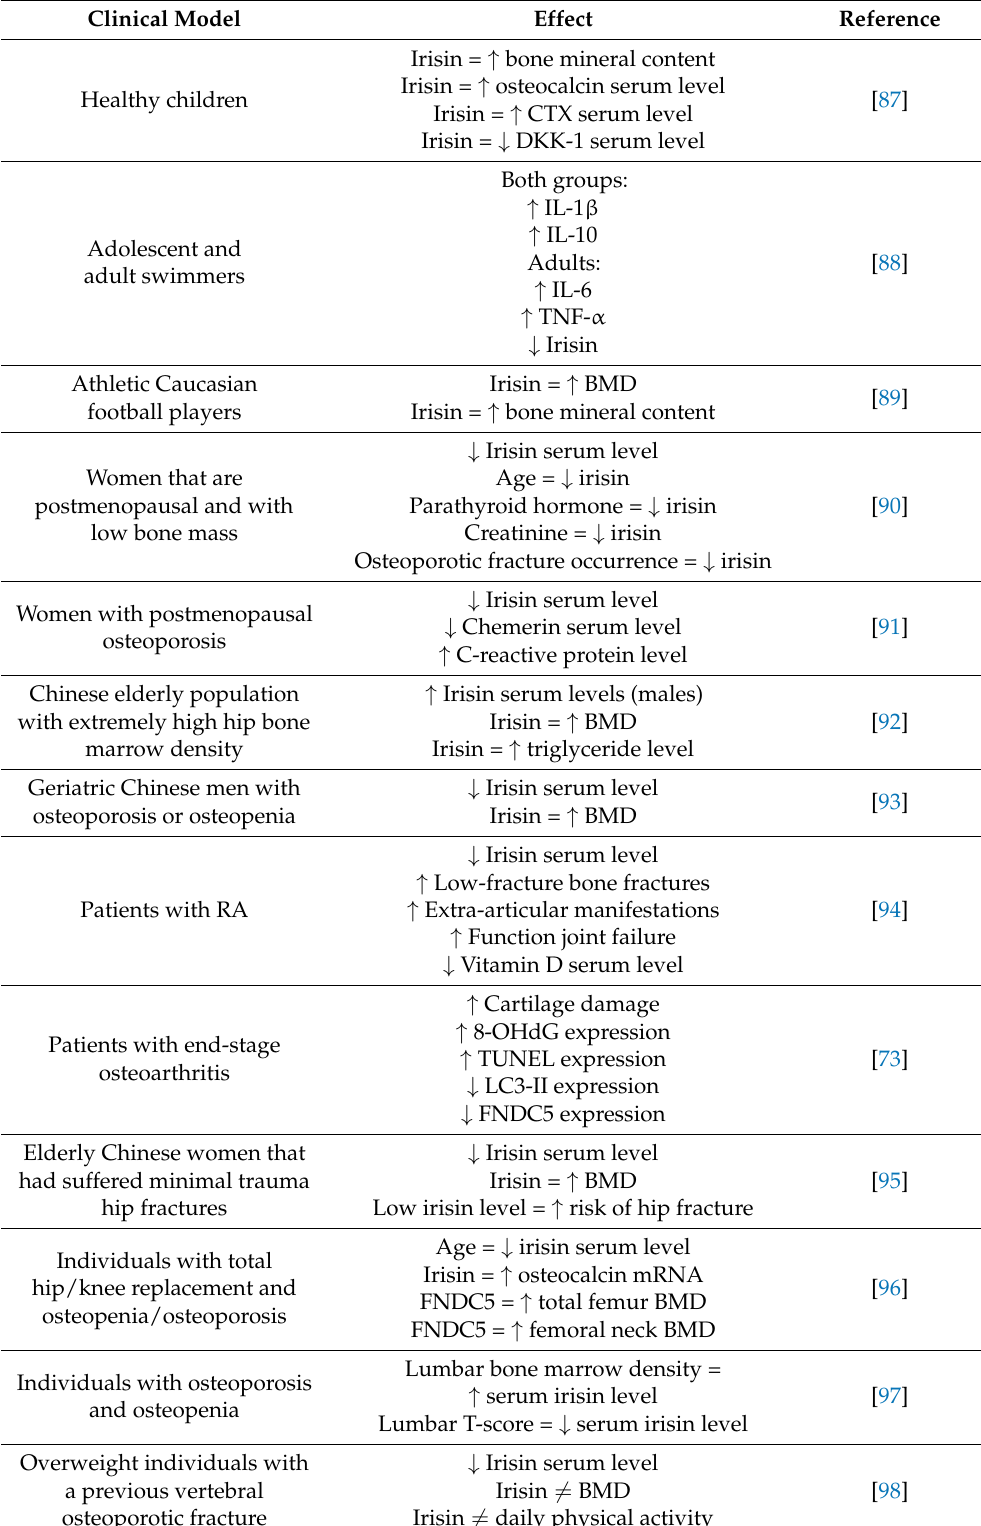
Table 6. Role of Irisin on bone homeostasis: clinical